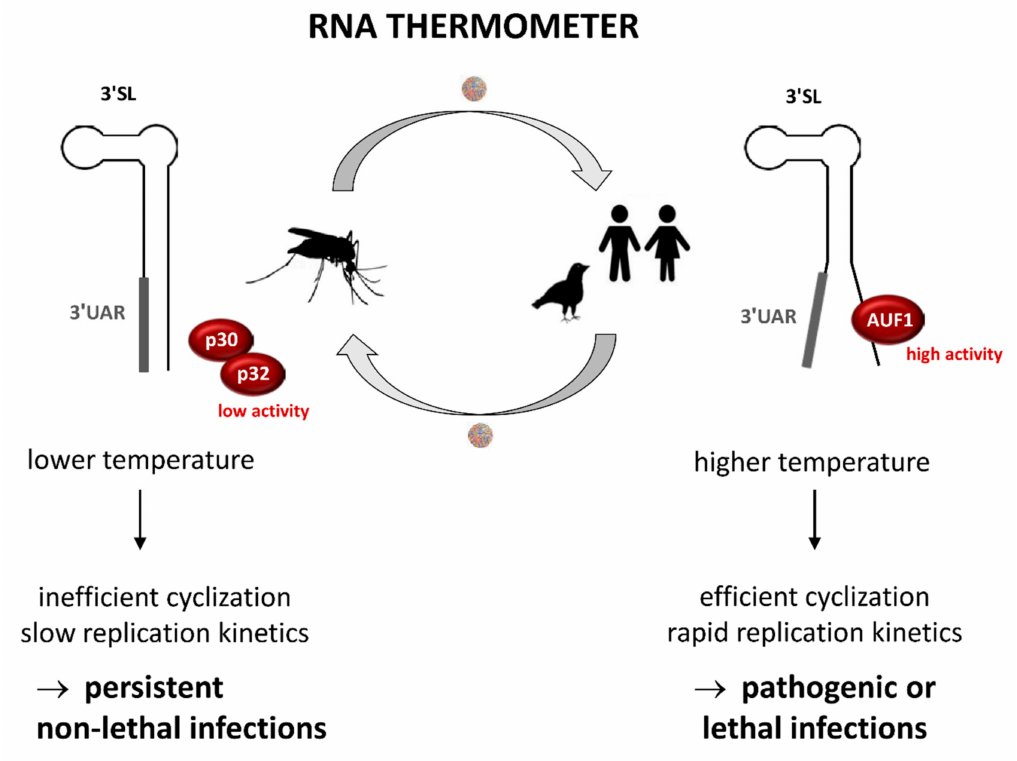
Figure 9. A model of the WNV 3 (cid:48) SL acting as an RNA thermometer during host switching. Due to the lower body temperature and low activities of p30 / p32 in the mosquito host, the 3 (cid:48) SL exhibits a higher stability, which leads to ine ffi cient cyclization and slow replication kinetics. In this way, persistent non-lethal infections in mosquitos can be established. In vertebrate hosts the higher body temperature and the strong activity of AUF1 renders the 3 (cid:48) SL more flexible. Consequently, cyclization is e ffi